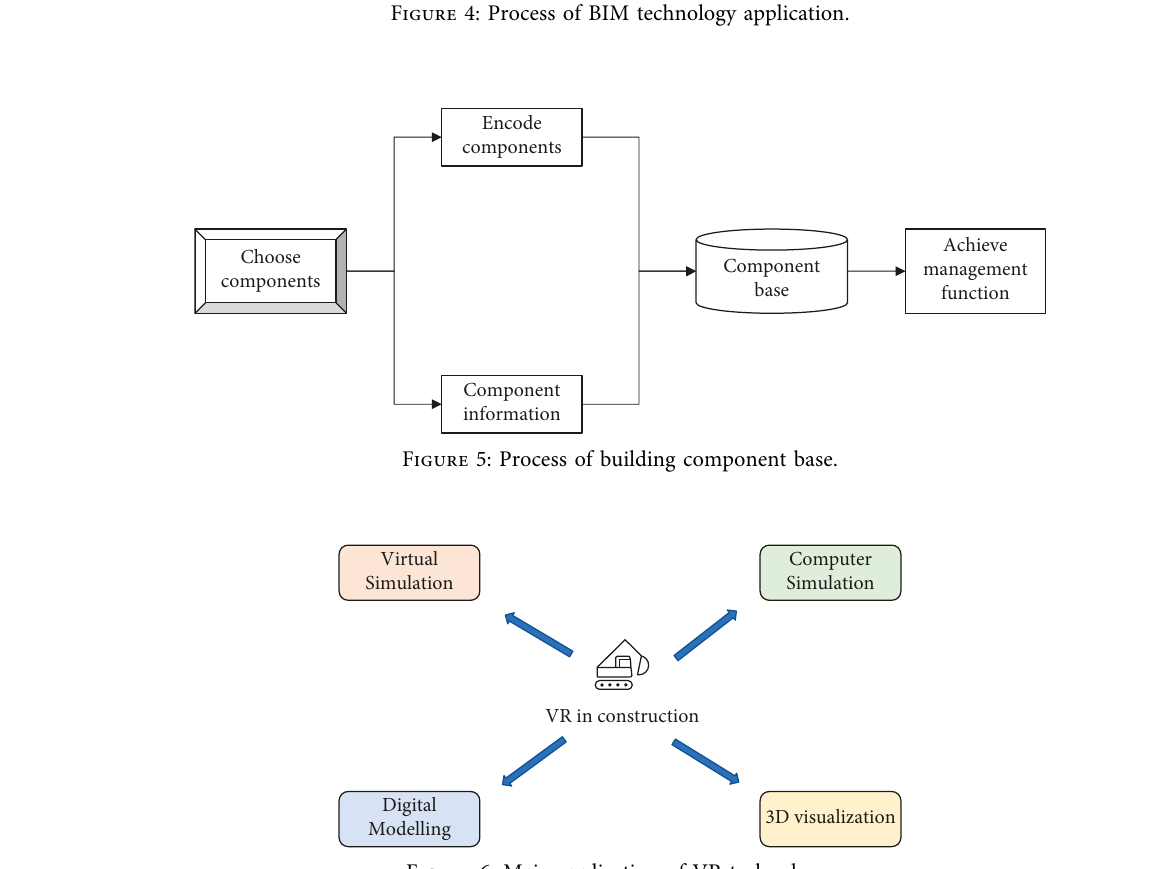
Figure 4: Process of BIM technology